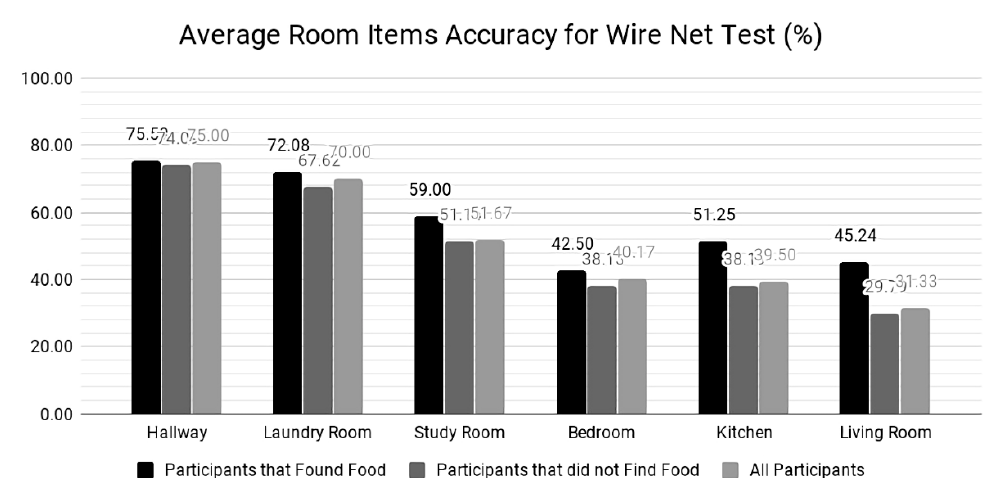
Figure 10. Average accuracy of room items size and placement by all participants.